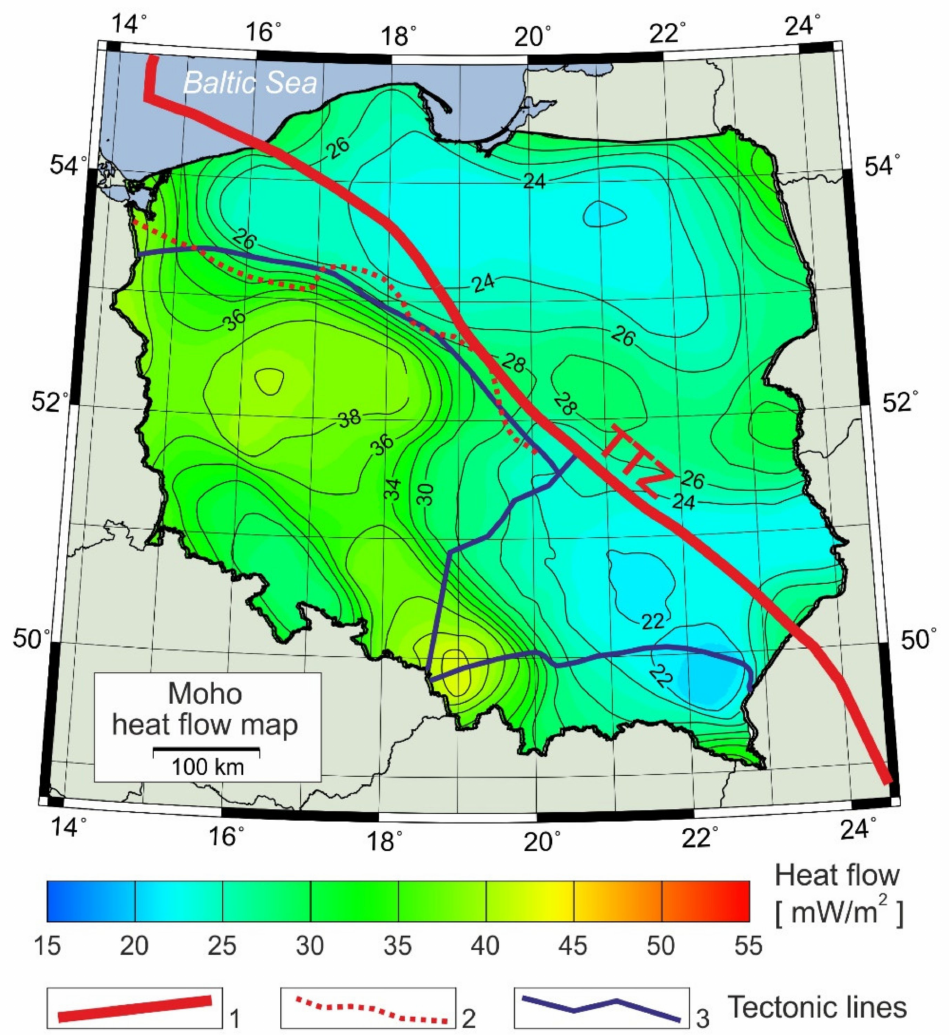
Figure 8. Moho heat flow map of Poland (redrafted and color scale modified from Majorowicz et al., 2019, [18]. Tectonic lines: 1—position of the TTZ in Poland according Narkiewicz [38], 2—magnetic line, southern margin of the Pomeranian Massif after Kr ó likowski [27], 3—basement borders after Karnkowski (2008,